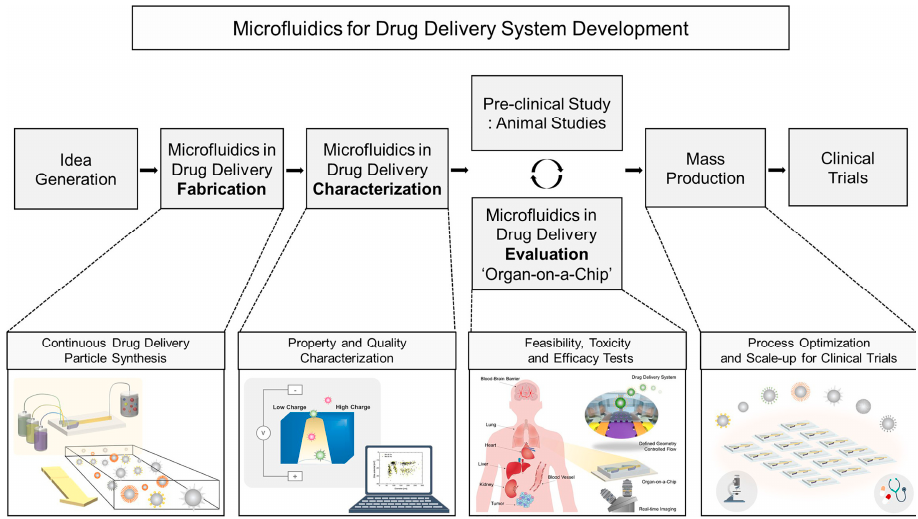
Figure 1. The pipeline of microfluidics for drug delivery [40].